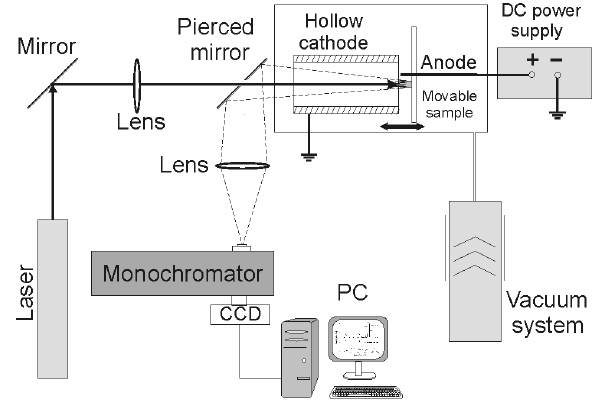
Figure 1 : Experimental setup of the combined LIP-HCD